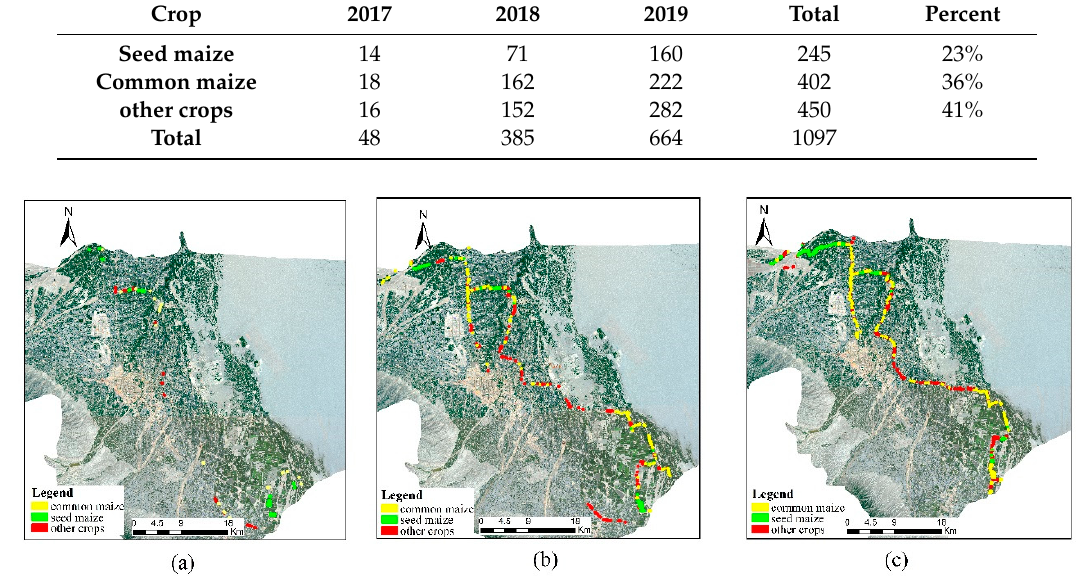
Figure 2. The spatial distribution of crop samples in Liangzhou in ( a ) 2017; ( b ) 2018; ( c) 2019.